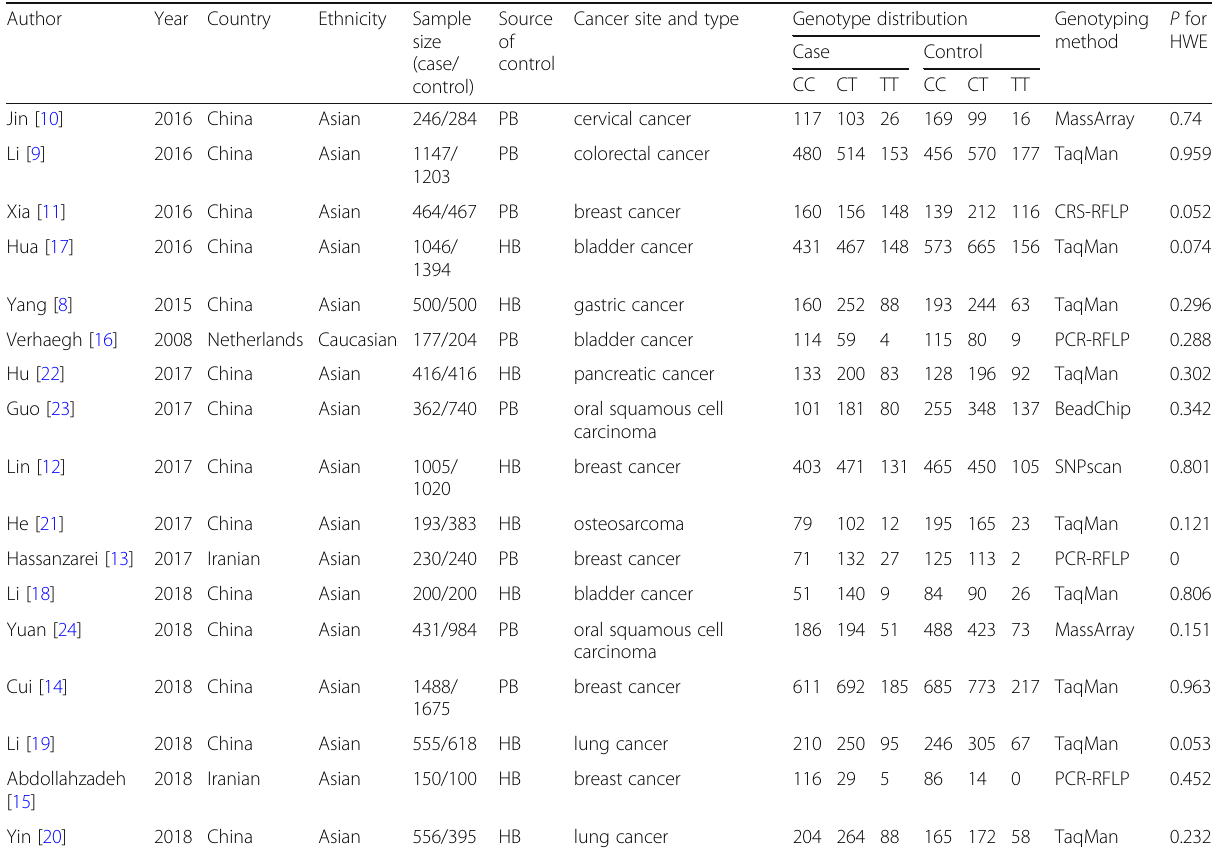
Table 1 Characteristics of included studies in the meta-analysis (rs217727